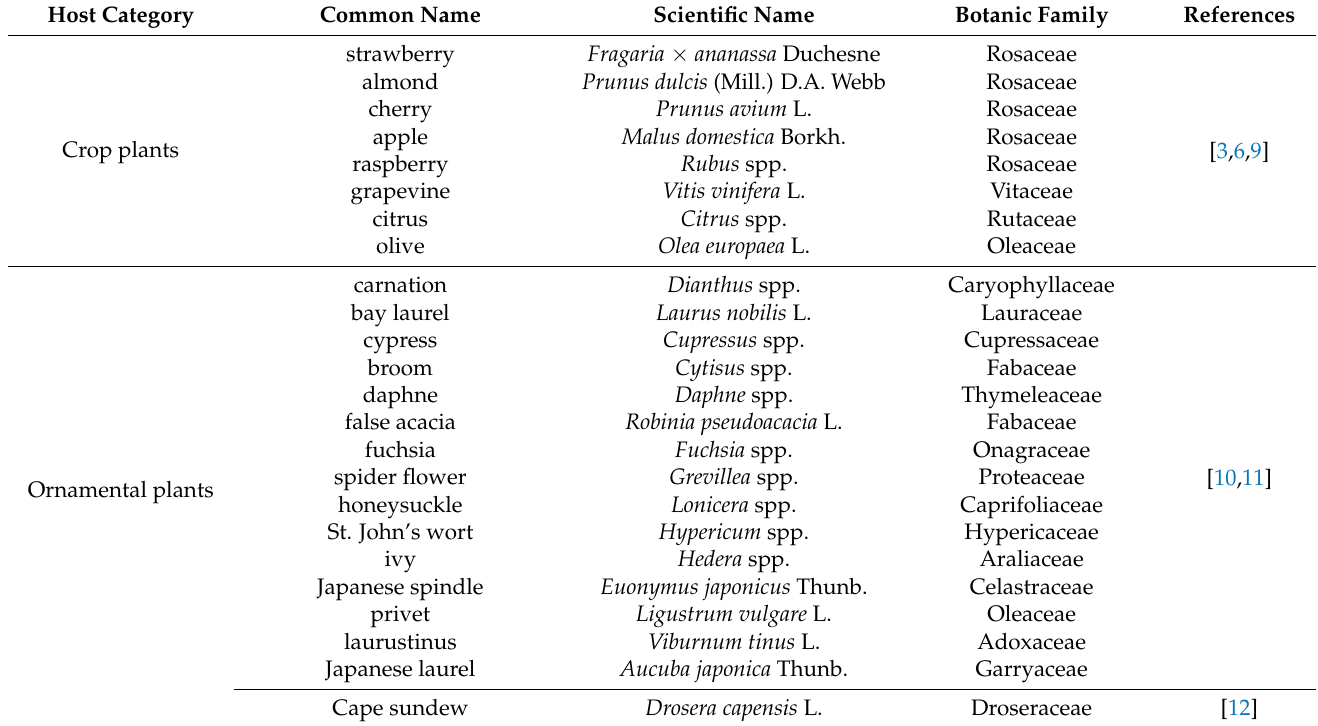
Table 1. Non extensive host-plant list of Cacoecimorpha pronubana